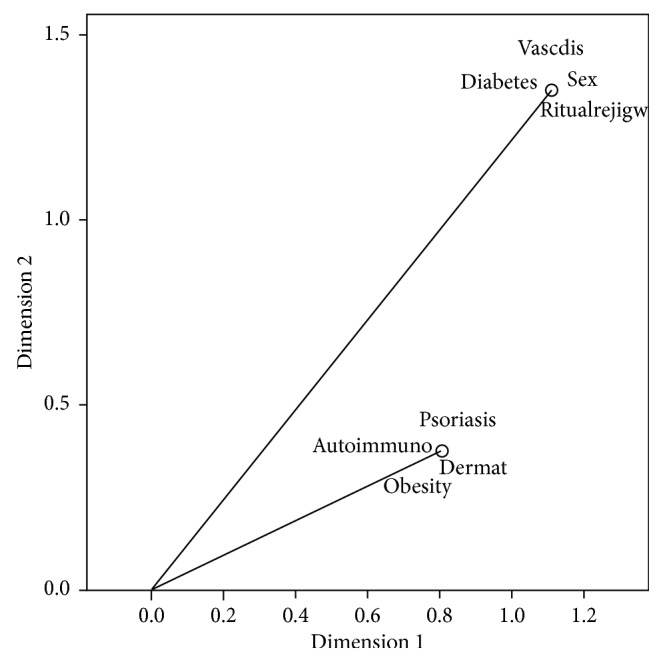
Multiple correspondence analysis of factors associated with foot mycosis.